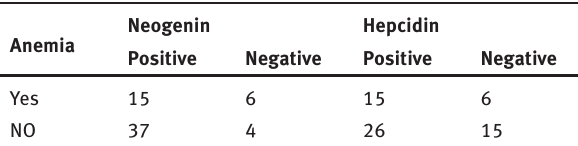
Table 2: Correlation between anemia and Hepcidin and Neogenin Expression in colorectal cancer